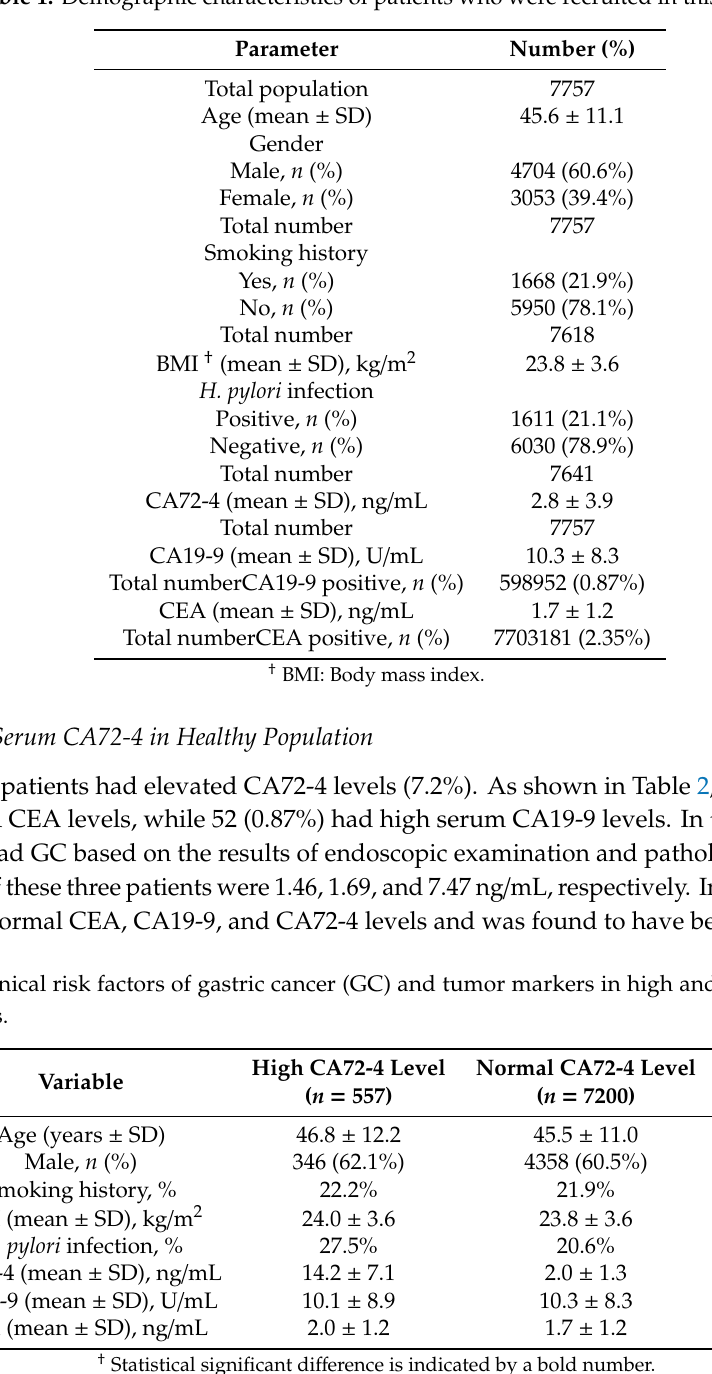
Table 1. Demographic characteristics of patients who were recruited in this study.